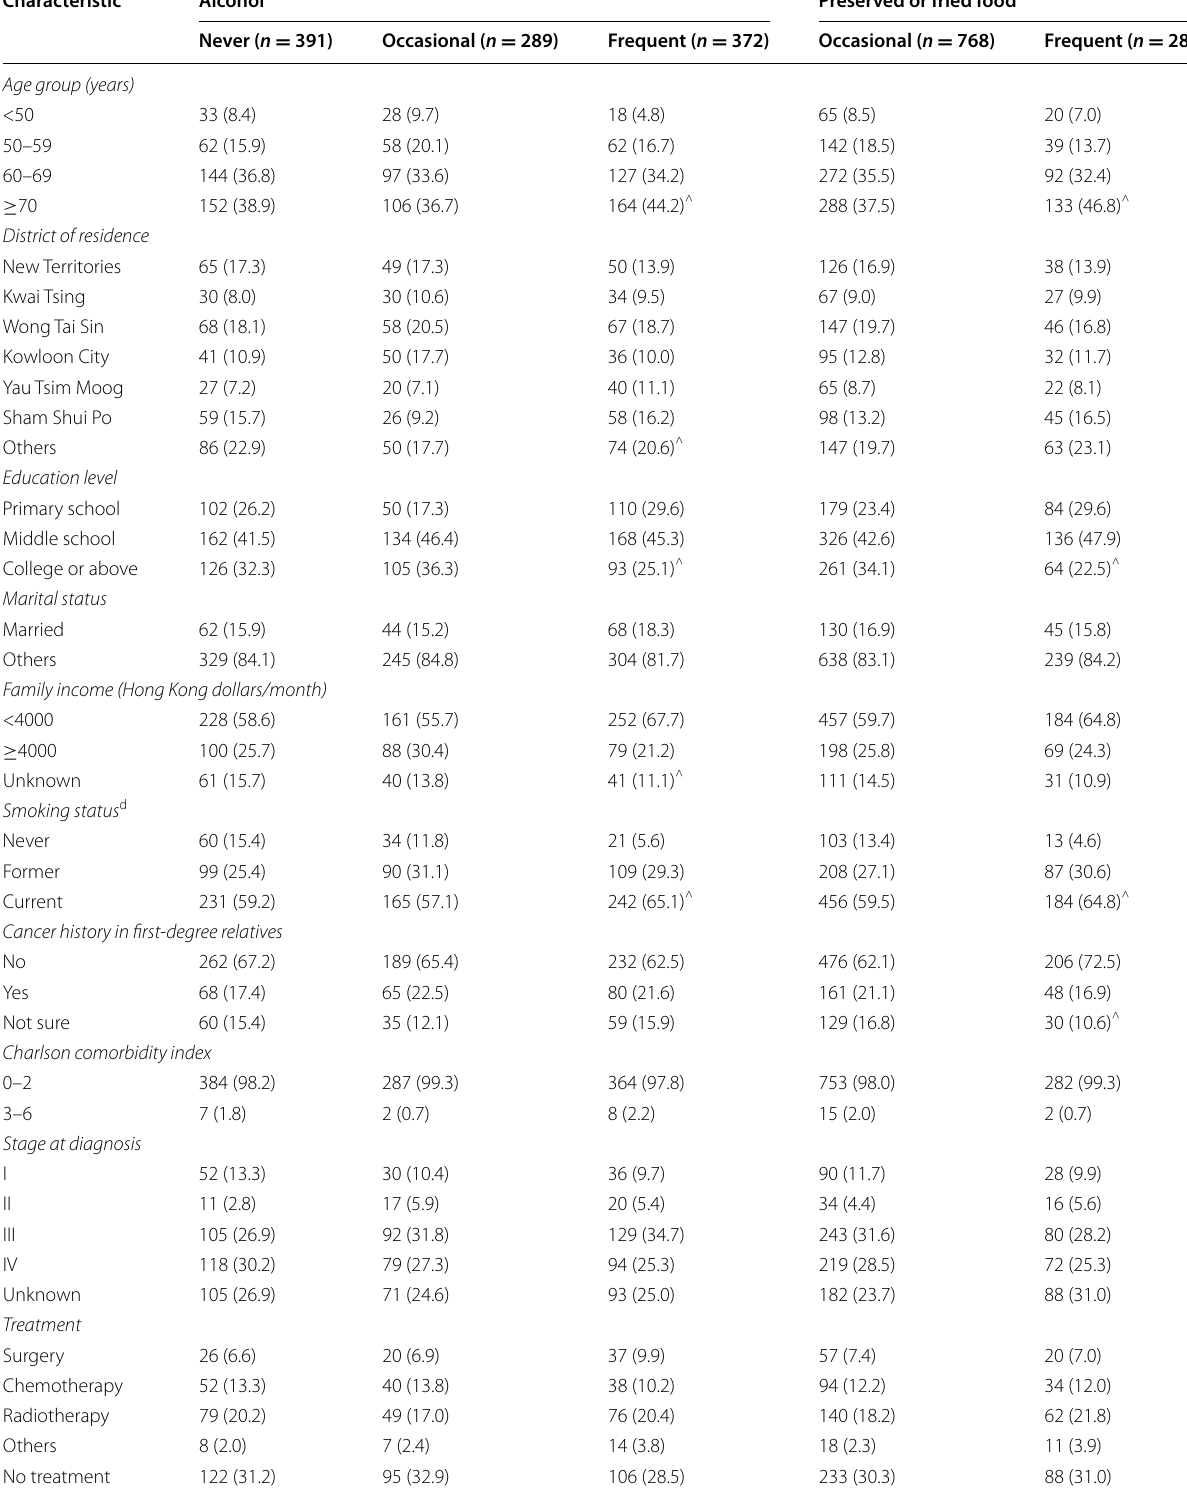
Table 1 Baseline demographic and clinical characteristics of 1052 Chinese men with lung cancer, grouped by level of alcohol consumption and consumption of preserved or fried